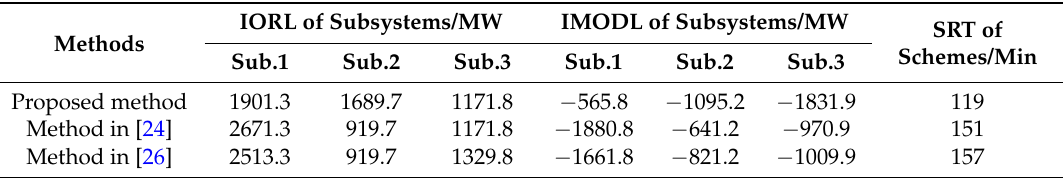
Table 3. Comparison of the proposed method with the methods in [24] and [26].